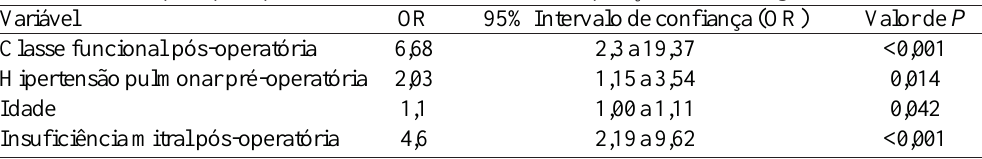
Tabela 2. Fatores pré e pós-operatórios associados ao risco de reoperação durante o seguimento.